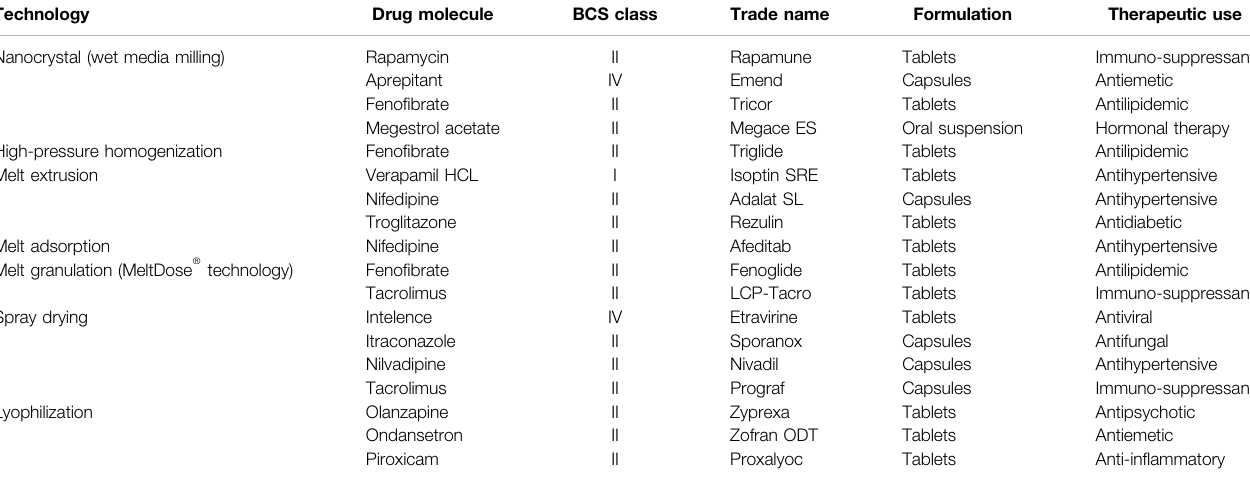
TABLE 7 | Representative examples of solid dispersion formulations.